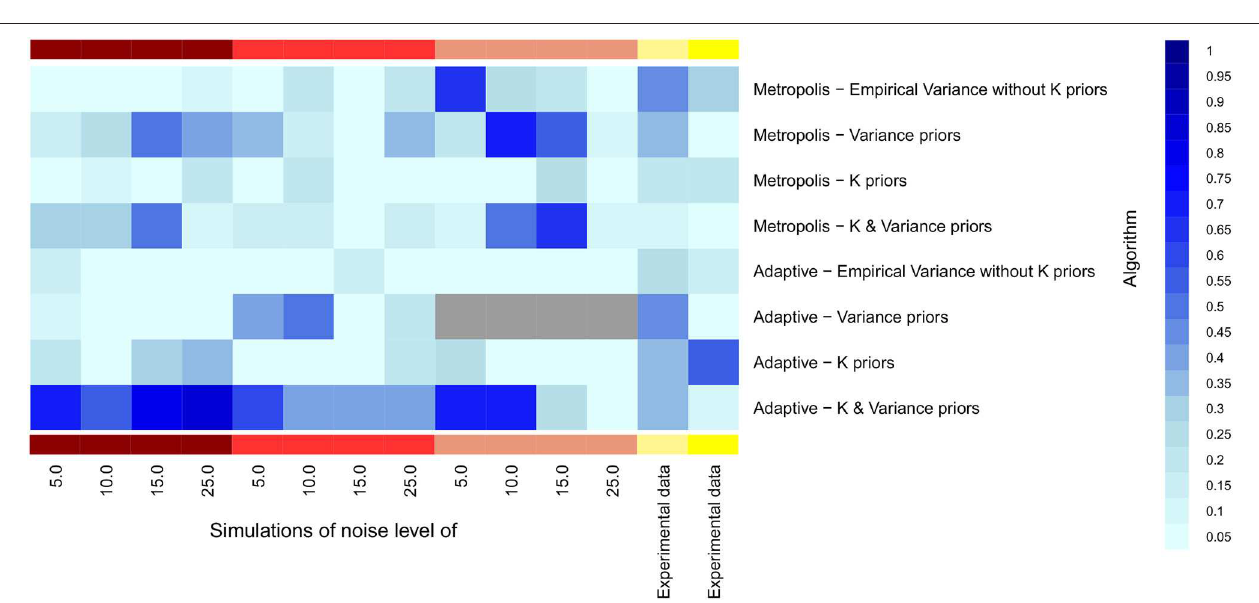
FIGURE 8 | Heatmap for the fraction of true parameters lying into the 95% confidence interval of MCMC samples. Samples were estimated through different likelihood computation. X-axis is labeled with noise levels used in the five models, starting with model 1 and ending with models 4 (light yellow) and 5 (dark yellow).